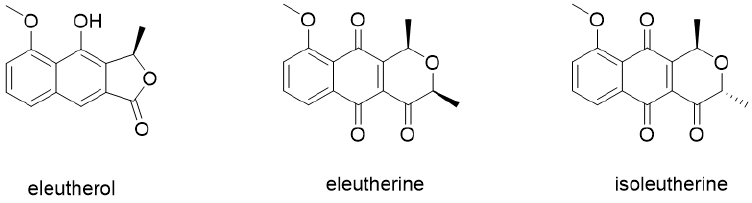
Figure 1. Chemical structures of eleutherol, eleutherine, and isoeleutherine.